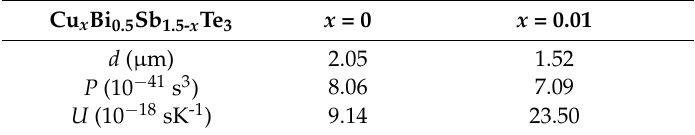
Table 1. Fitting parameters for low-temperature lattice thermal conductivity by using the Debye